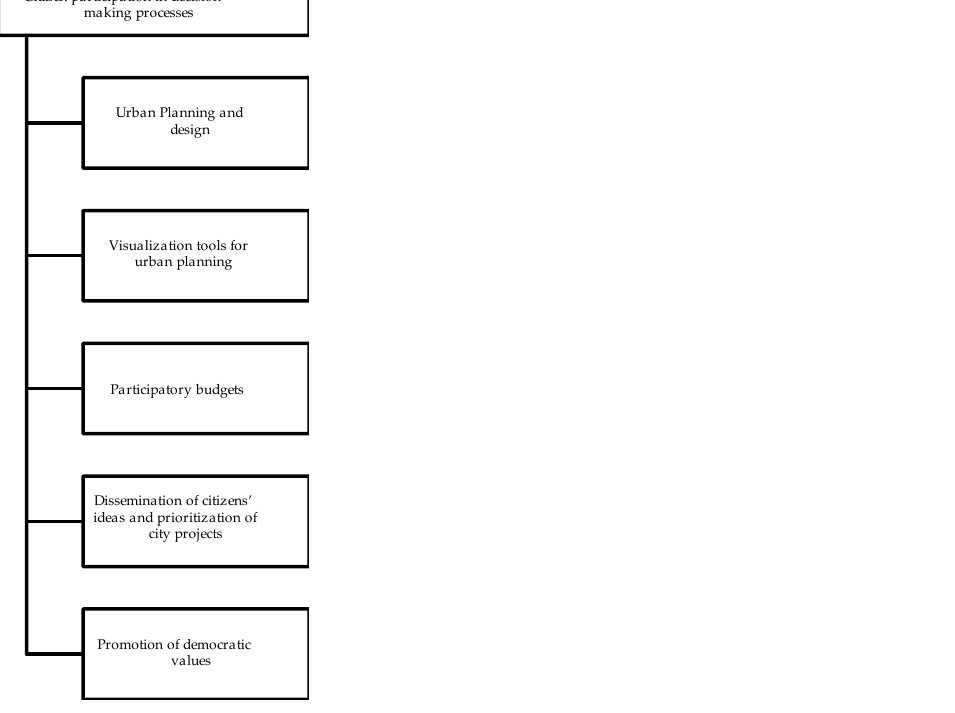
Figure 6. Types of collaborative approaches related to citizen participation in decision-making pro- cesses.